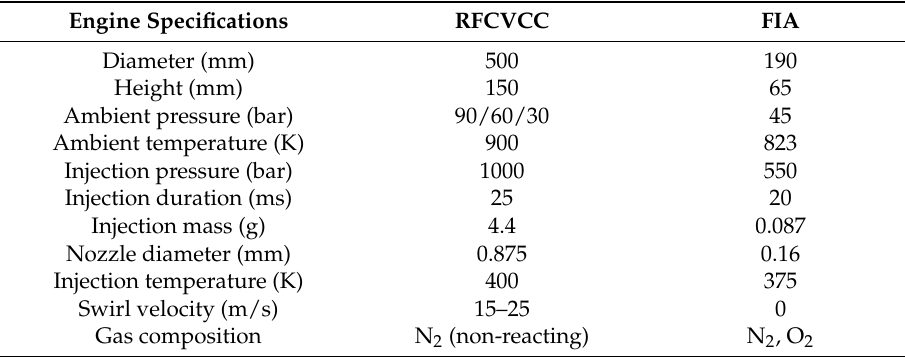
Table 1. Specifications and configurations of RFCVCC and